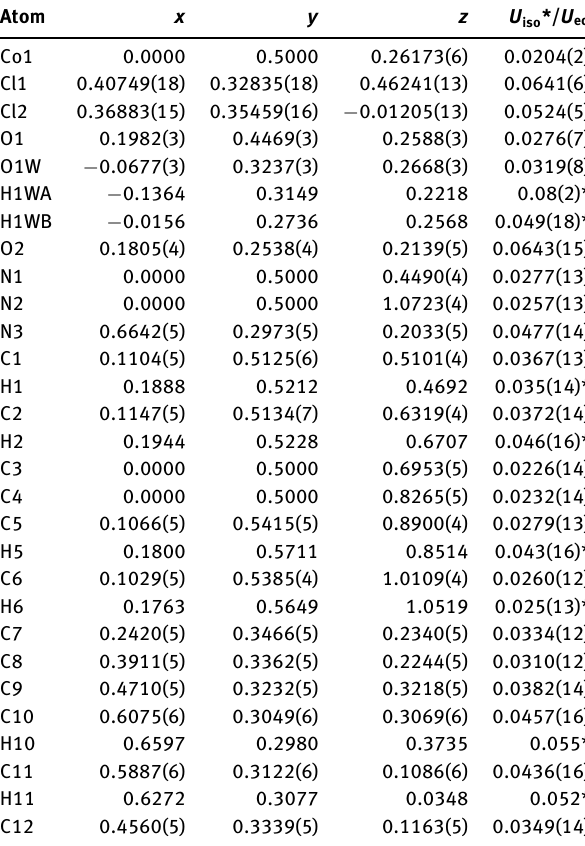
Table 2: Fractional atomic coordinates and isotropic or equivalent isotropic displacement parameters (Å 2